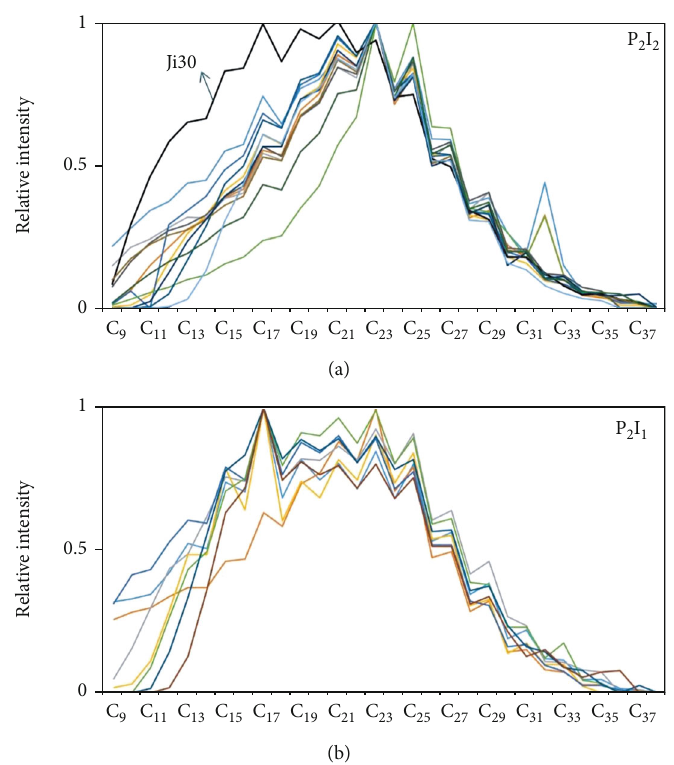
Figure 7: Distribution curve of n -alkanes of the (a) upper and (b) lower sweet crude oils in the Lucaogou Formation, Jimusaer Sag.